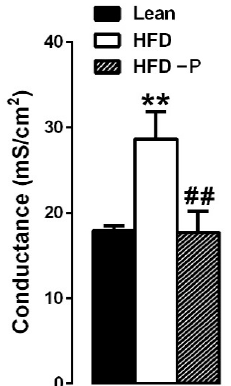
Figure 7. Effect of pistachio consumption on the conductance of isolated duodenal sections from the lean, HFD, and HFD-P mice through the Ussing chambers technique. Data are expressed as mean ± SEM; ( n = 8/group). (** p < 0.01); hash denotes significant difference compared with the HFD (## p < 0.01).